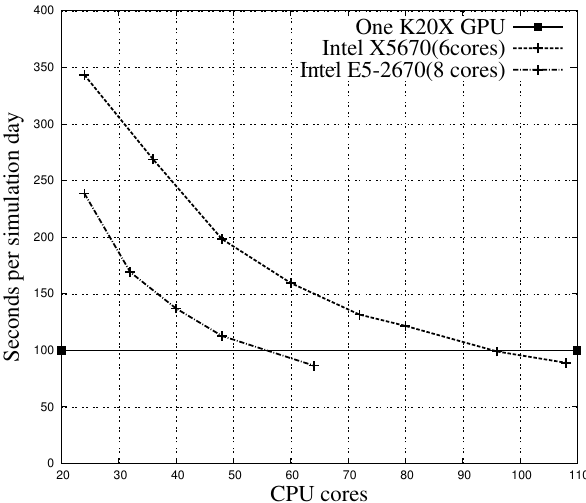
Figure 10. Performance comparison with different hardware plat-